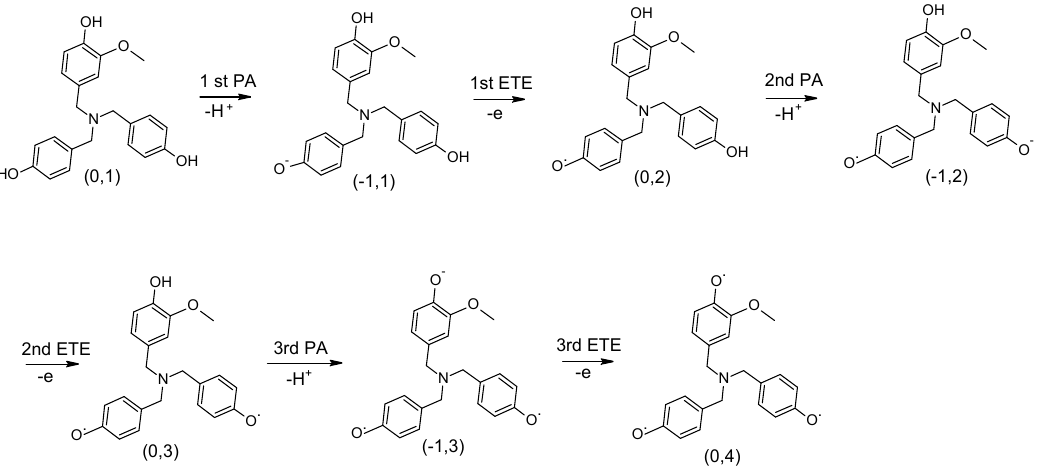
Figure 3. Scheme of the reference compound undergoing consecutive sequential proton loss electron transfer (SPLET) mechanisms. The order was determined based on the computed PA values shown in Table 3. At each step, charge and spin multiplicity of the resulting molecule are indicated in parenthesis (charge, spin multiplicity).